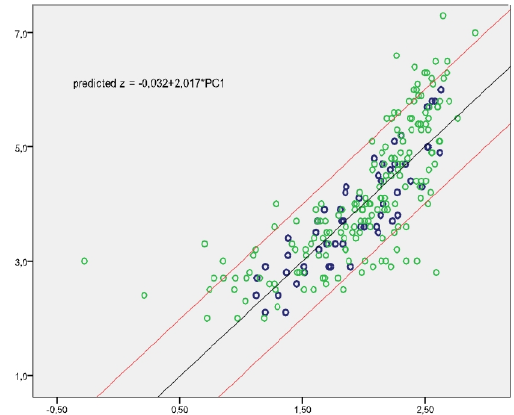
Figure 6. The graphic expression of confidence zone in area C. The symbolisms are given in figure 2.